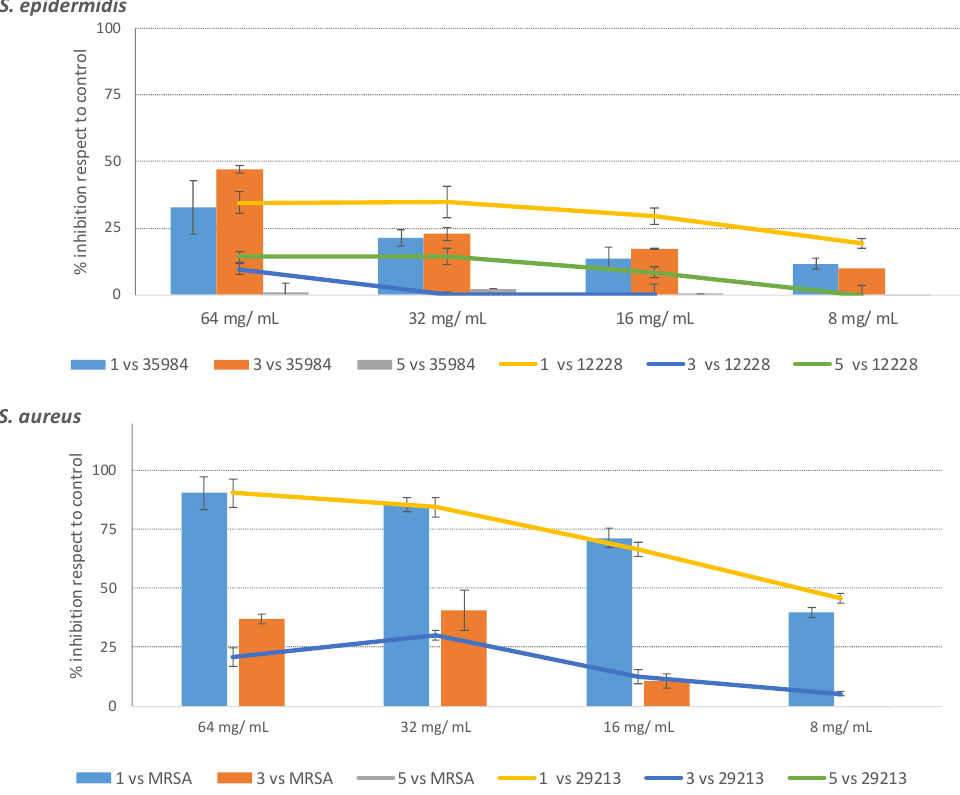
Figure 7. Purification and antimicrobial assessment of compounds ( 1 , 3 , 5 ) against S. epidermidis and S aureus